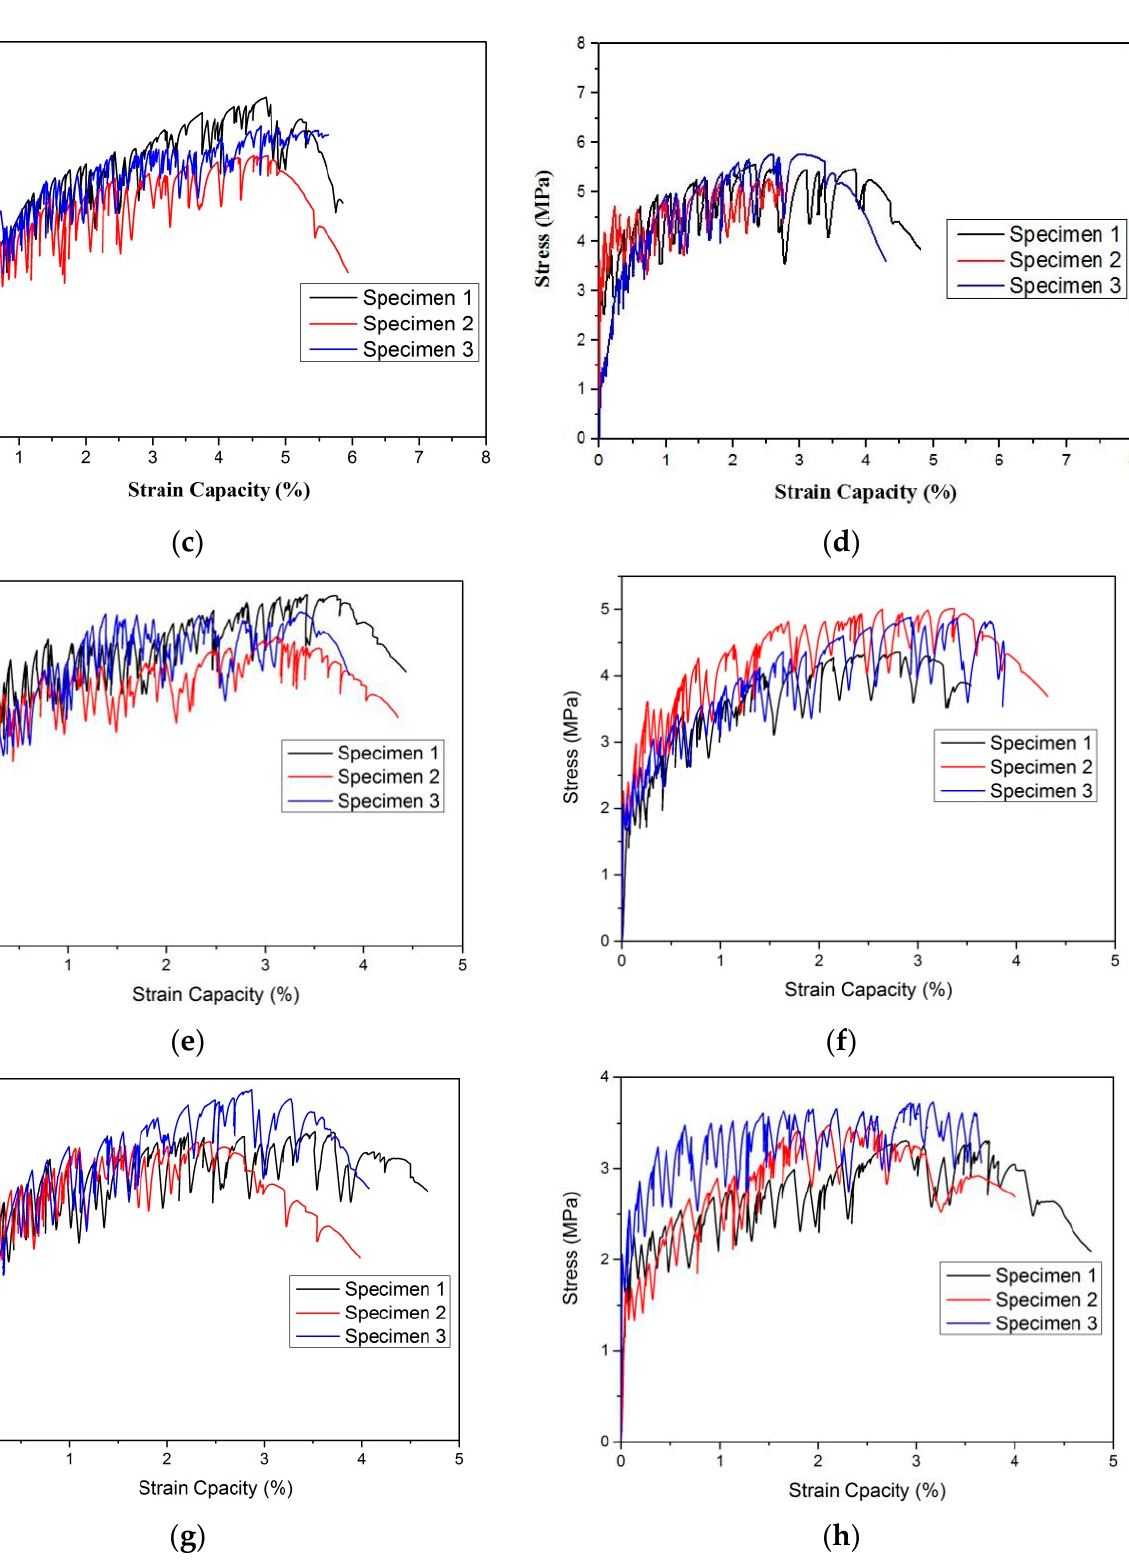
Figure 14. Tensile stress–strain curves of GLECC mixtures. ( a ) FAC0.15 − PE1.75; ( b ) FAC0.15 − PE1.5; ( c ) FAC0.15 − PE1.25; ( d ) FAC0.15 − PE1; ( e ) FAC0.3 − PE1.5; ( f ) FAC0.3 − PE1; ( g ) FAC0.45 − PE1.25; ( h ) FAC0.45 − PE1.